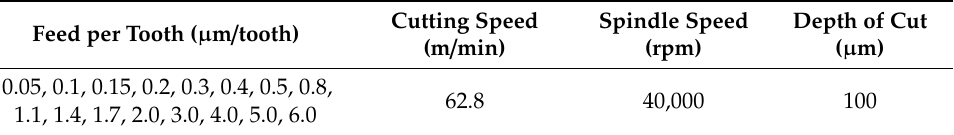
Table 3. Cutting conditions for the size e ff ect